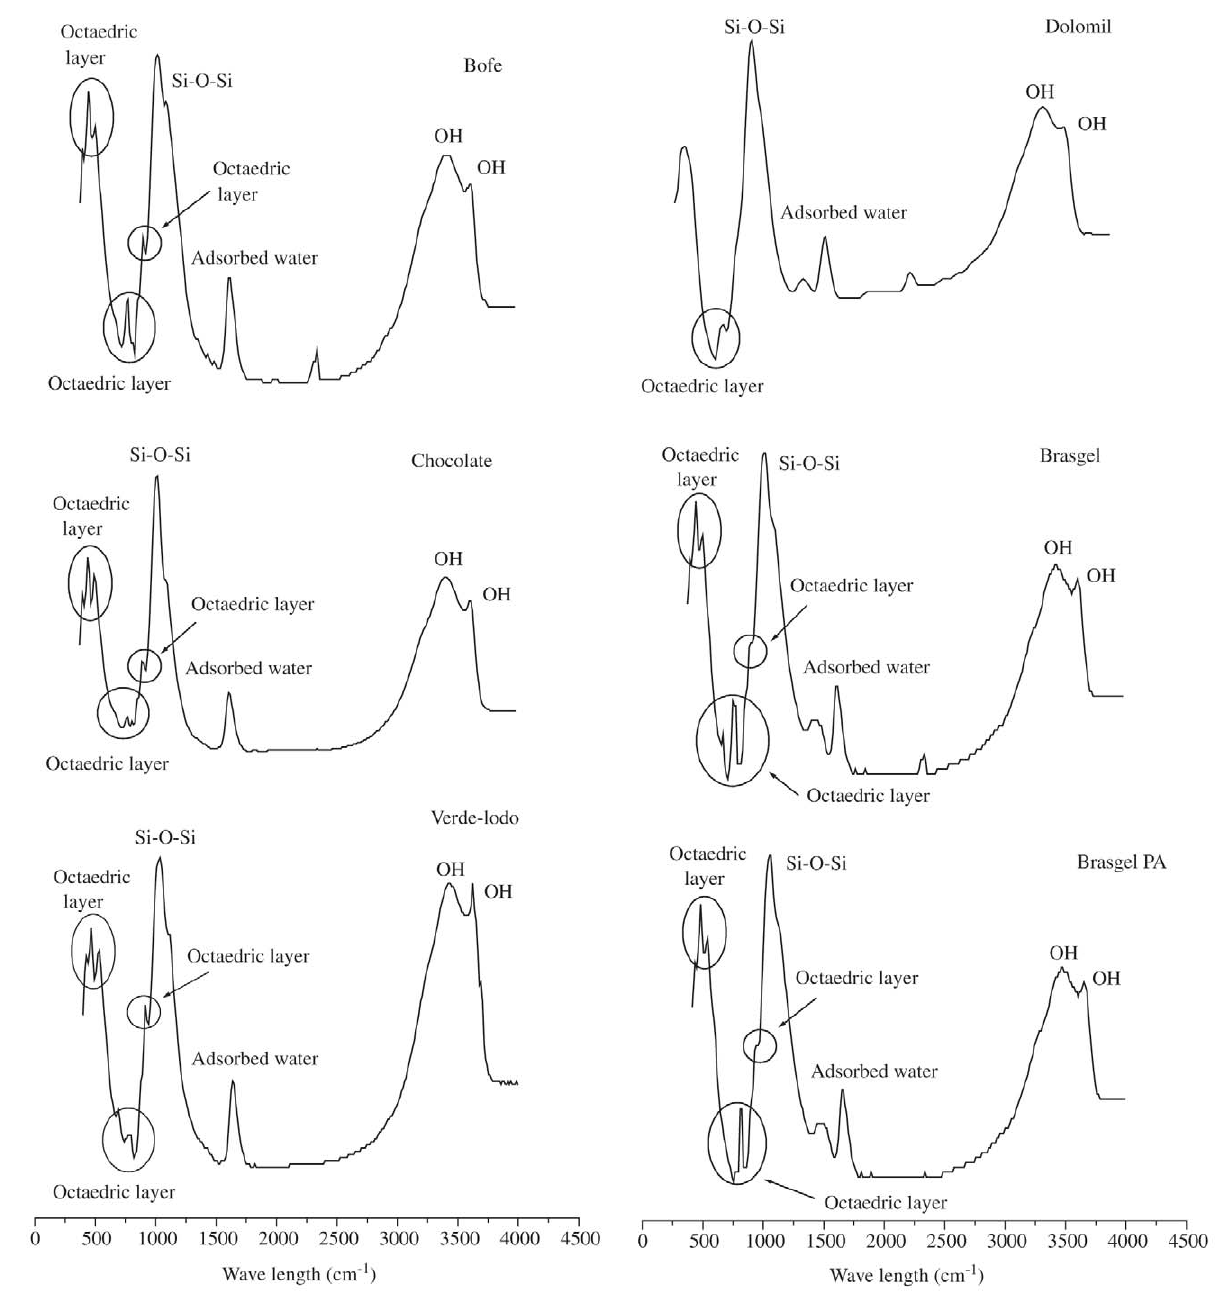
Figure 4. Infrared spectrums for the bentonite samples: a) Bofe ; b) Chocolate ; c) Verde-lodo ; d) Dolomil ; e) Brasgel; f) Brasgel PA